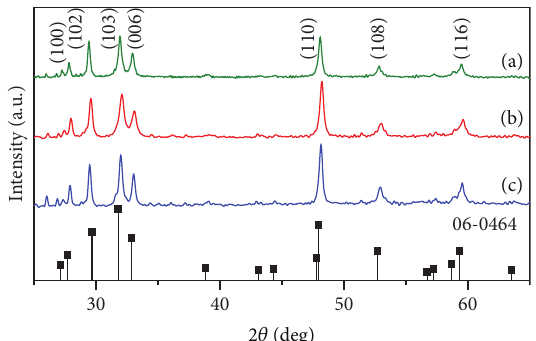
Figure 1: XRD patterns of CuS nanostructures (a) without CTAB for 5 hrs, (b) with CTAB for 5 hrs, and (c) with CTAB for 24 hrs.